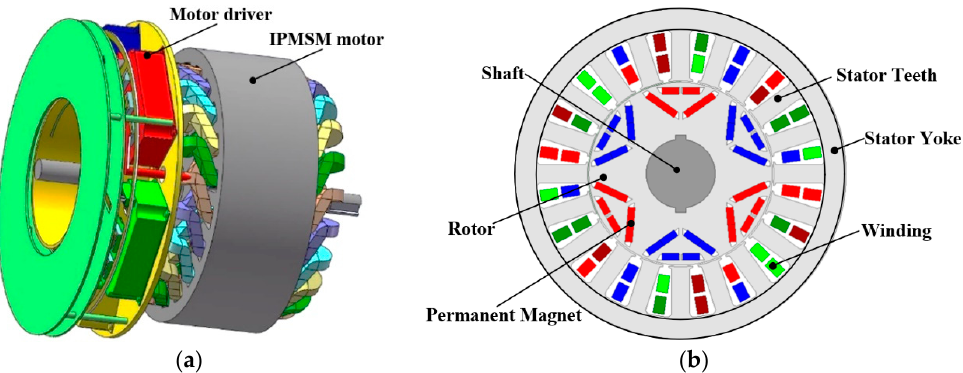
Figure 8. Ver2.0 type topology: ( a ) IMDS overall structure, ( b ) Ver2.0 IPMSM motor